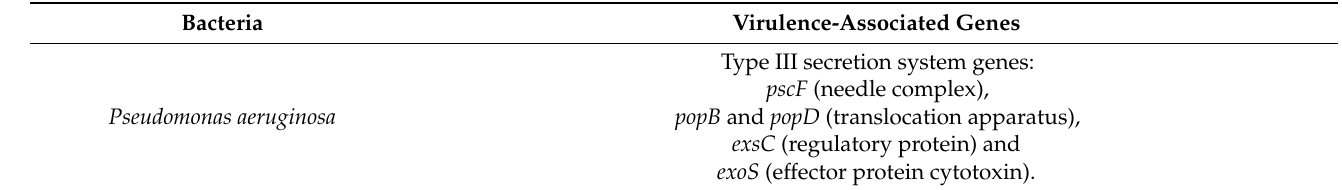
Table 2. Virulence-associated genes regulated by Lon protease in bacterial